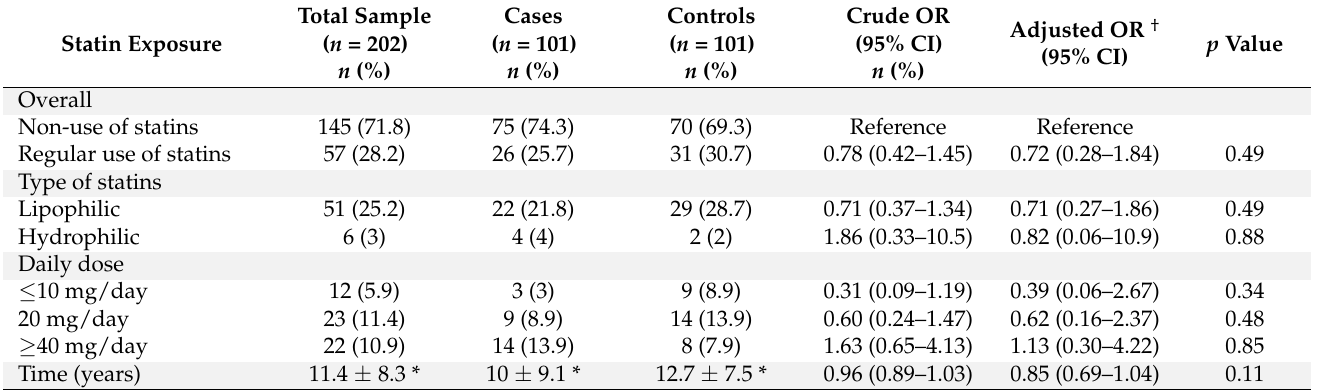
Table 4. Prevalence of statin exposure among cases and controls and adjusted logistic regression models (OR) for the association between statin exposure and head and neck cancer